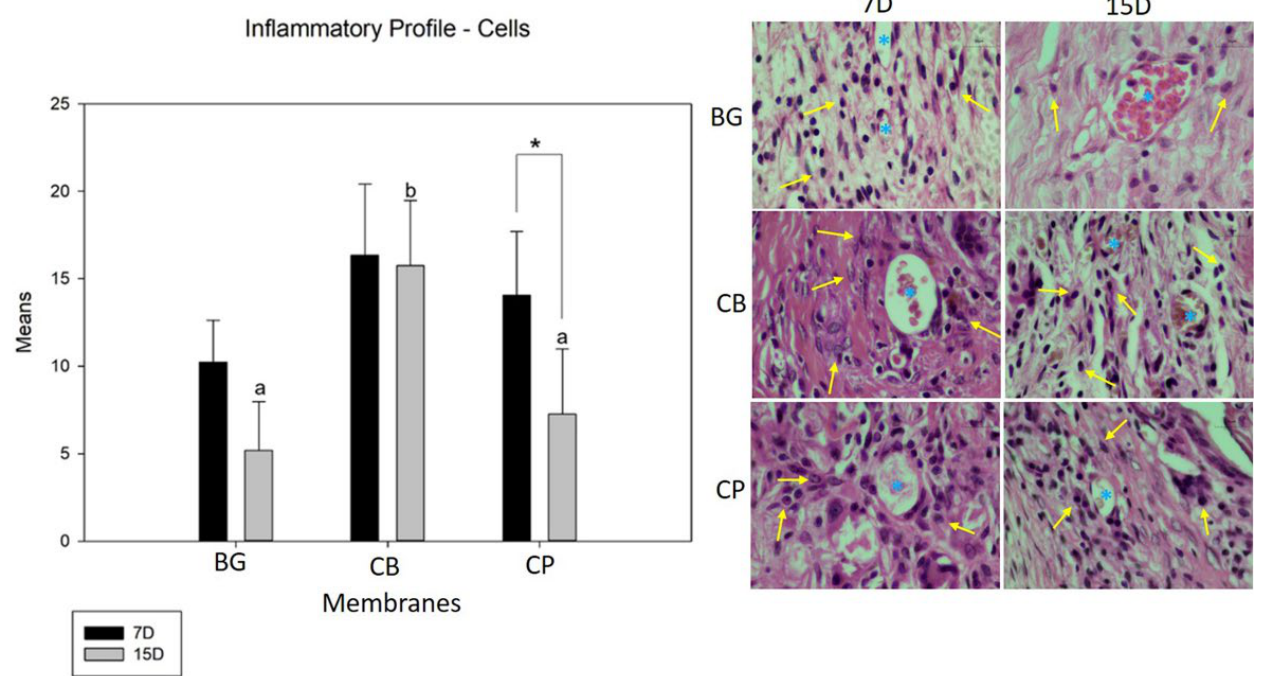
Figure 2. The graph shows the comparisons of the means and standard deviation within and be- tween groups for the analysis of inflammatory cells (lymphocytes) in the period of 7 and 15 days. The lowercase letters represent the statistically significant differences between groups for the period of 15 days ( p < 0.002), the * demonstrates whether there is a statistically significant difference within the group in the period from 7 to 15 days ( p = 0.006). In the photomicrographs at 100× magnification, the yellow arrows ( ) indicate the cells (lymphocytes) and the * indicates blood ⇑